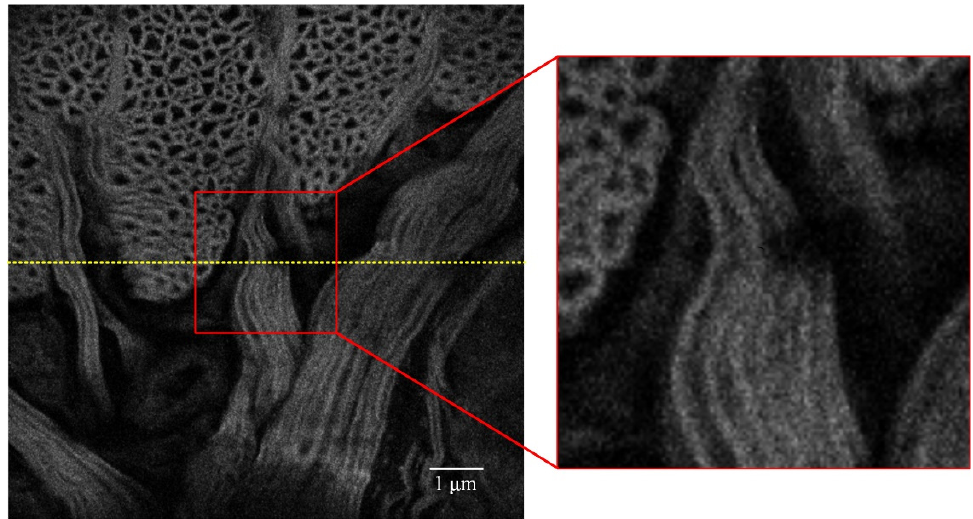
Figure 8. Imaging result after correction with 100 iterations of the adaptive coefficient SPGD algo- rithm, and the grayscale variance value is about 9.0.